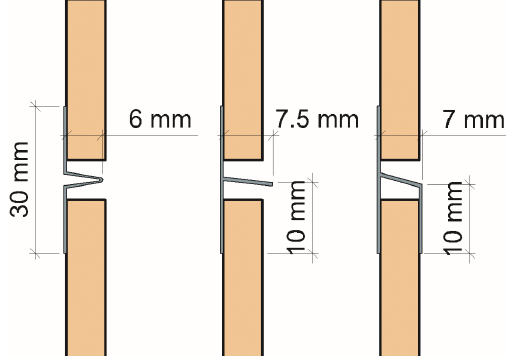
Figure 5. Joint profile dimensions. From the left: T1-profile, T2-profile and h-profile. Left side of panels is the interior side, and right side is the exterior. Altered from [12].